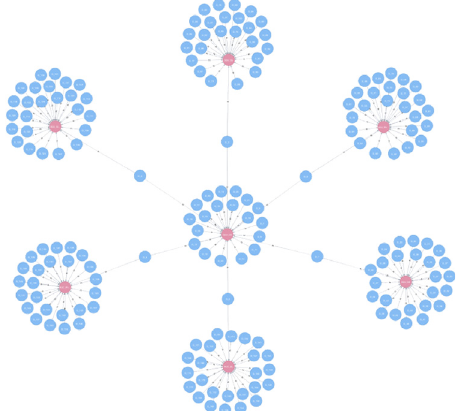
Figure 6. The schematic diagram of the rim chain network in